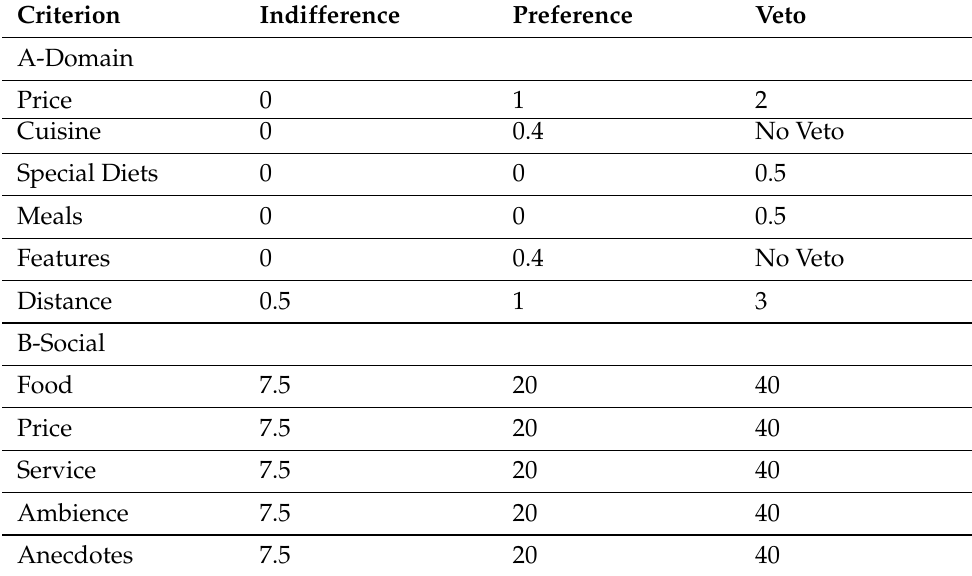
Table 8. The values of the ELECTRE thresholds for all